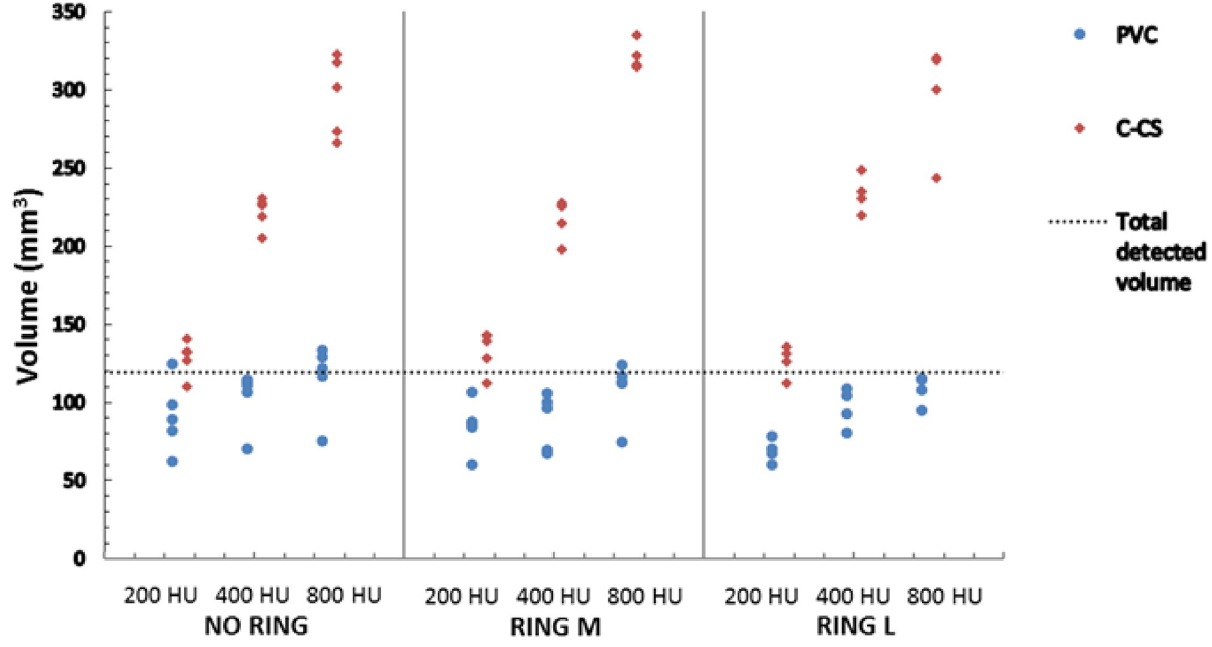
Fig 6. Scatter plots of the determined calcium volumes for the total detected volume (98,2 + 21,2 = 119,4 mm 3 ) of CACs with same HA density for the CEORA phantom using C-CS (red) and PVC-CS (blue). Plots are grouped per ring configuration (No ring, Ring M and Ring L). Each group shows volumes determined for three HA densities of the inserts (800, 400 and 200 mg/cm 3